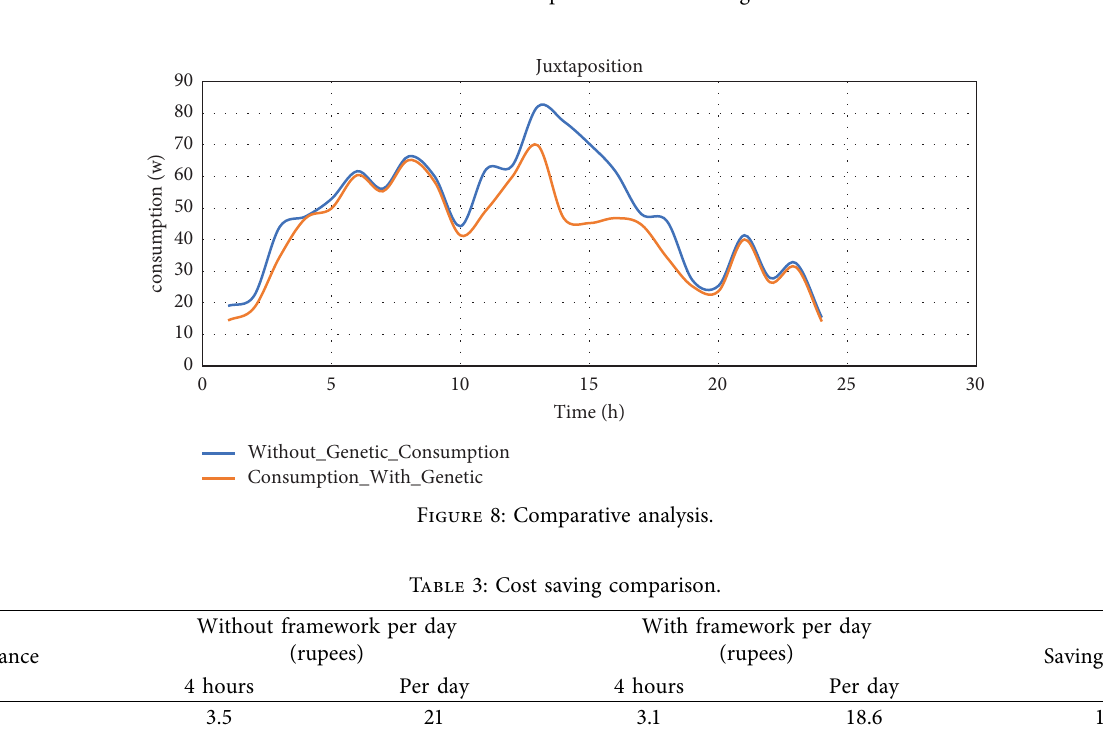
Figure 7: Consumption with scheduling.